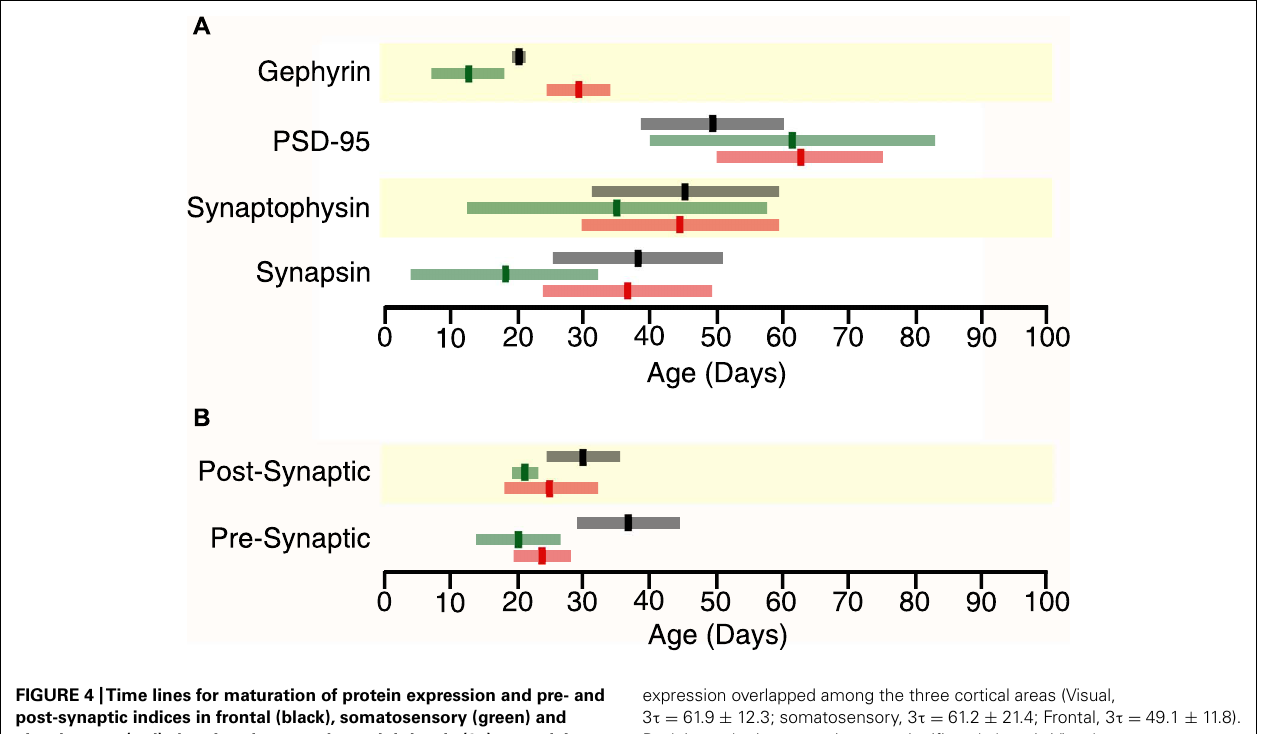
FIGURE 4 |Time lines for maturation of protein expression and pre- and post-synaptic indices in frontal (black), somatosensory (green) and visual cortex (red) showing the age when adult levels (3 τ ) or peak in expression were reached (bright bars) and the standard error (light bars) around the 3 τ s or peak (light bars) (A)Adult levels of synapsin expression overlapped among the three cortical areas (Visual, 3 τ = P37.2 ± 12.6; somatosensory cortex, 3 τ = P19.0 ± 14.9; Frontal, 3 τ = P37.6 ± 13.5). Adult levels of synaptophysin expression overlapped among the three cortical areas (Visual, 3 τ = P44.8 ± 15.1; somatosensory, 3 τ = P34.7 ± 22.2; Frontal, 3 τ = P45.4 ± 14.2). Adult levels of PSD-95